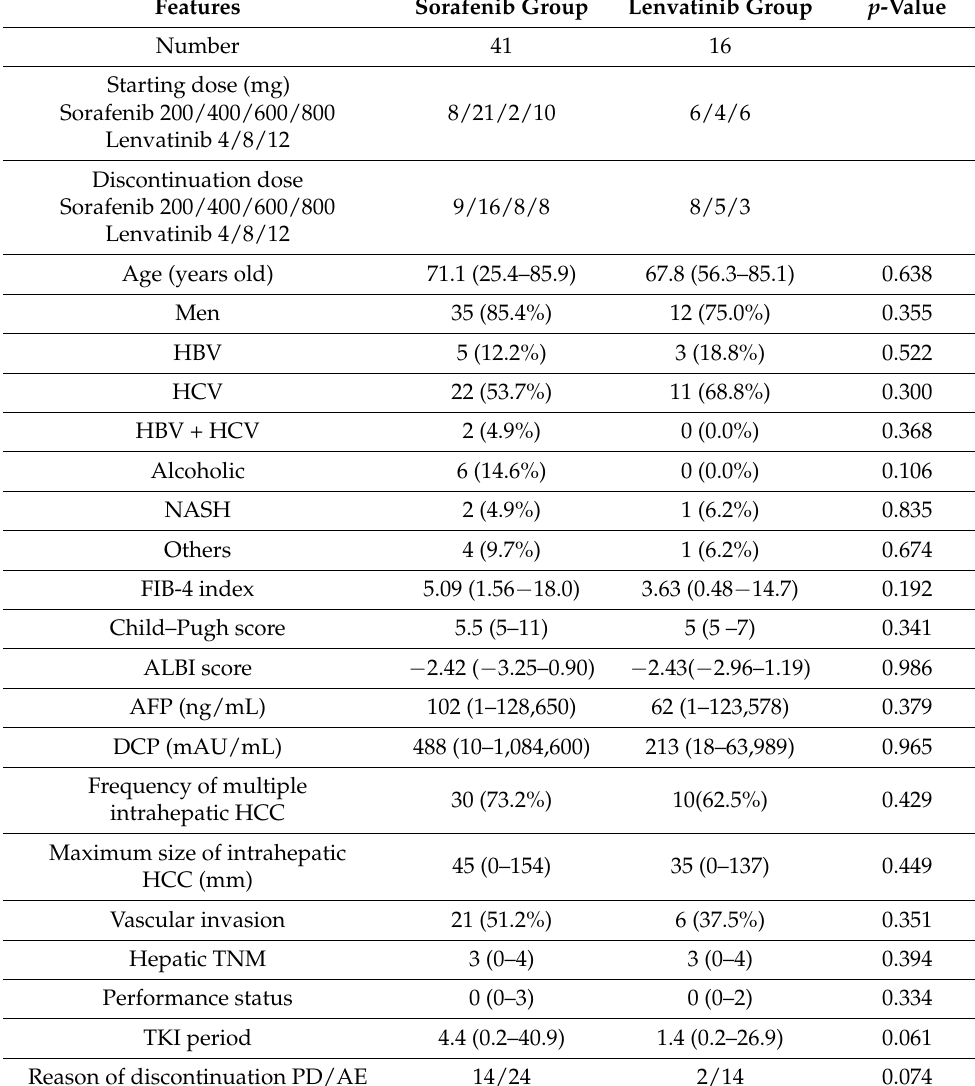
Table 4. Background data of patients who received sorafenib or